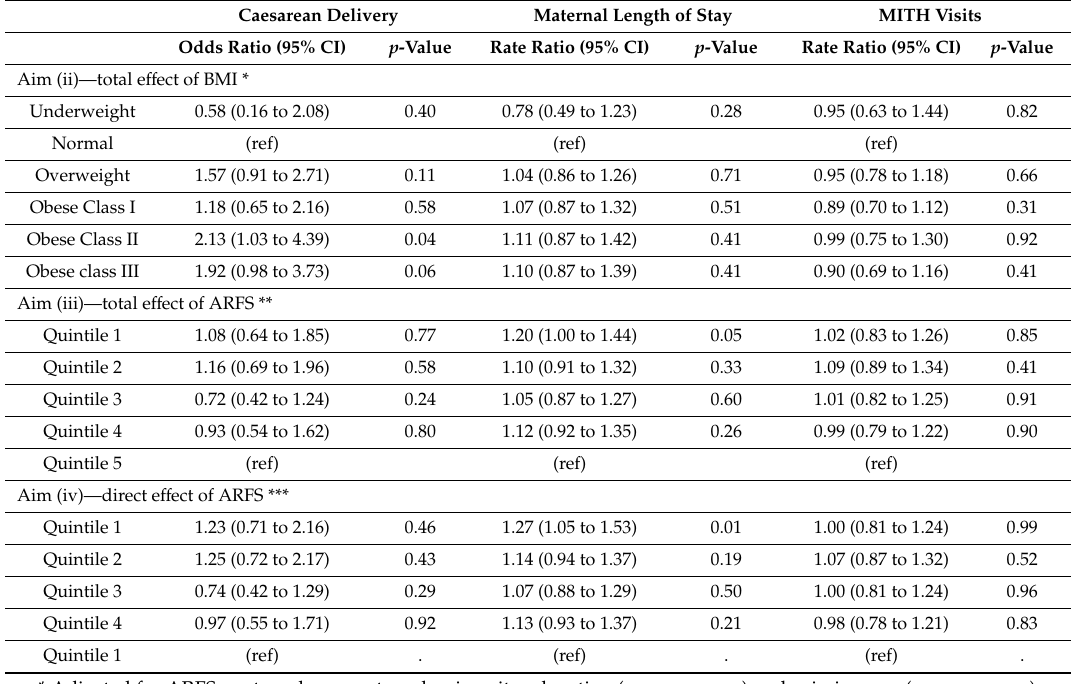
Table 4. Estimates of the e ff ect of diet quality and pre-pregnancy BMI on healthcare-resource use. Caesarean Delivery Maternal Length of Stay MITH Visits Odds Ratio (95% CI) p -Value Rate Ratio (95% CI) p -Value Rate Ratio (95% CI) p